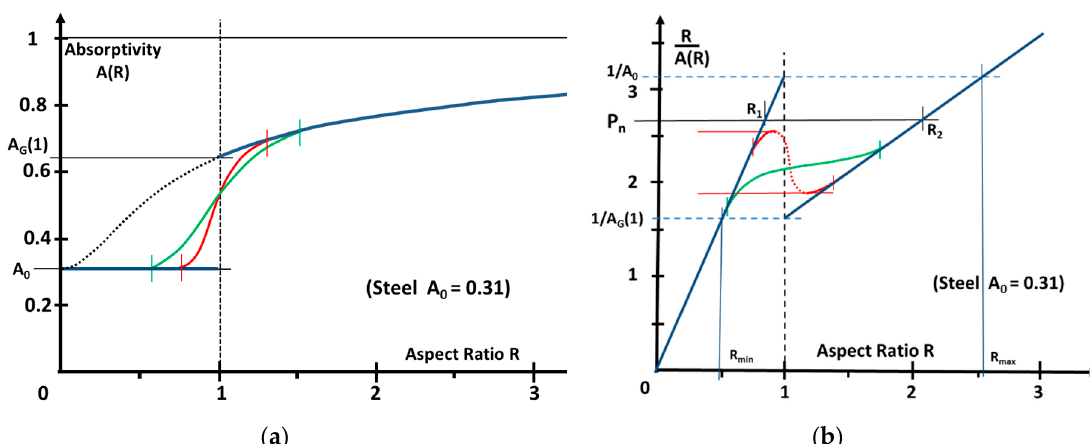
Figure 9. ( a ) Three examples of variation of the absorptivity A(R) around R = 1. Blue curve: discontinuous variation from A 0 to A G (1) at R = 1. Red curve: smooth but rather sharp transition around R = 1. Green curve: much smoother transition. Dotted curve: Gouffé’s absorptivity for a cone (for steel, λ = 1.03 µm). ( b ) Corresponding evolutions of R/A(R) for these three cases of variation of the absorptivity. (A 0 ≈ 0.31 for steel at λ = 1.06 µm is used, and A G (1) is the absorptivity given by the Gouffé’s law at R = 1).